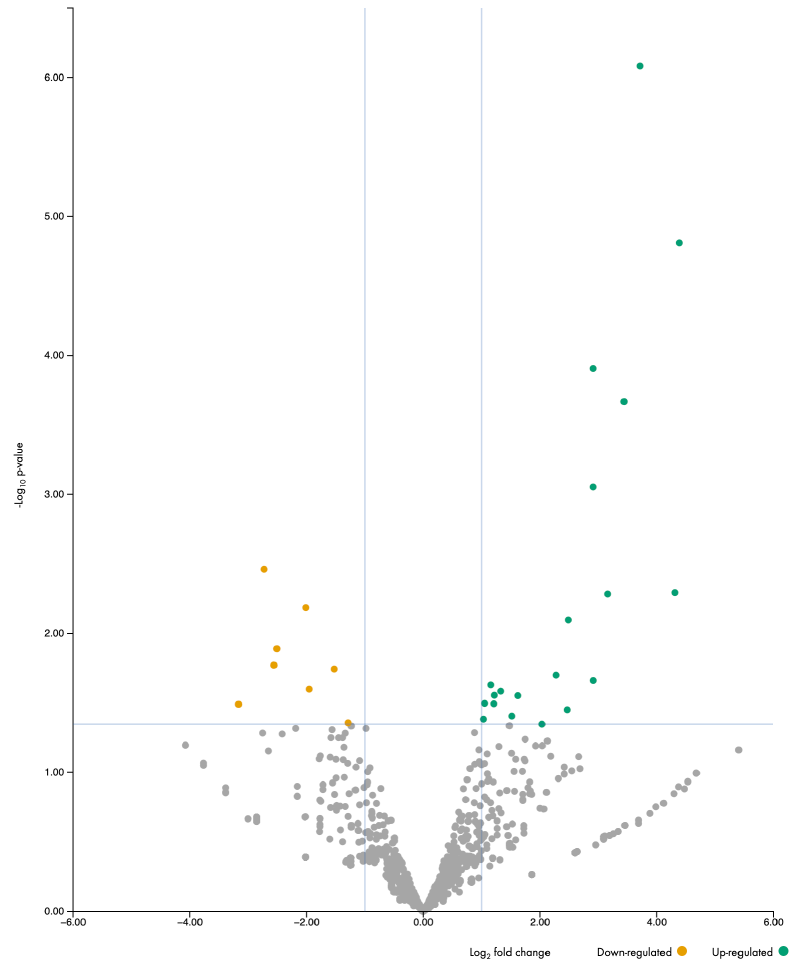
Figure 3. A volcano plot demonstrating dysregulated miRNAs after ICH, compared to sham. A total of 28 miRNAs exhibited a difference ( p < 0.05) in their expression between ICH and sham. The serum levels of 20 miRNAs were found to be significantly increased (green dots) and serum levels of 8 miRNAs were significantly decreased (yellow dots) after ICH, in comparison to sham ( p < 0.05; fold-change ≥ 2).